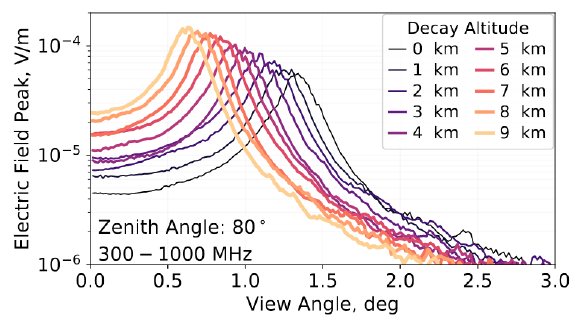
Figure 6. Peak electric fi eld value for τ -lepton induced air show- ers with an 80 ◦ zenith angle and varied decay altitudes generated by ZHAireS for use in the ν SpaceSim framework